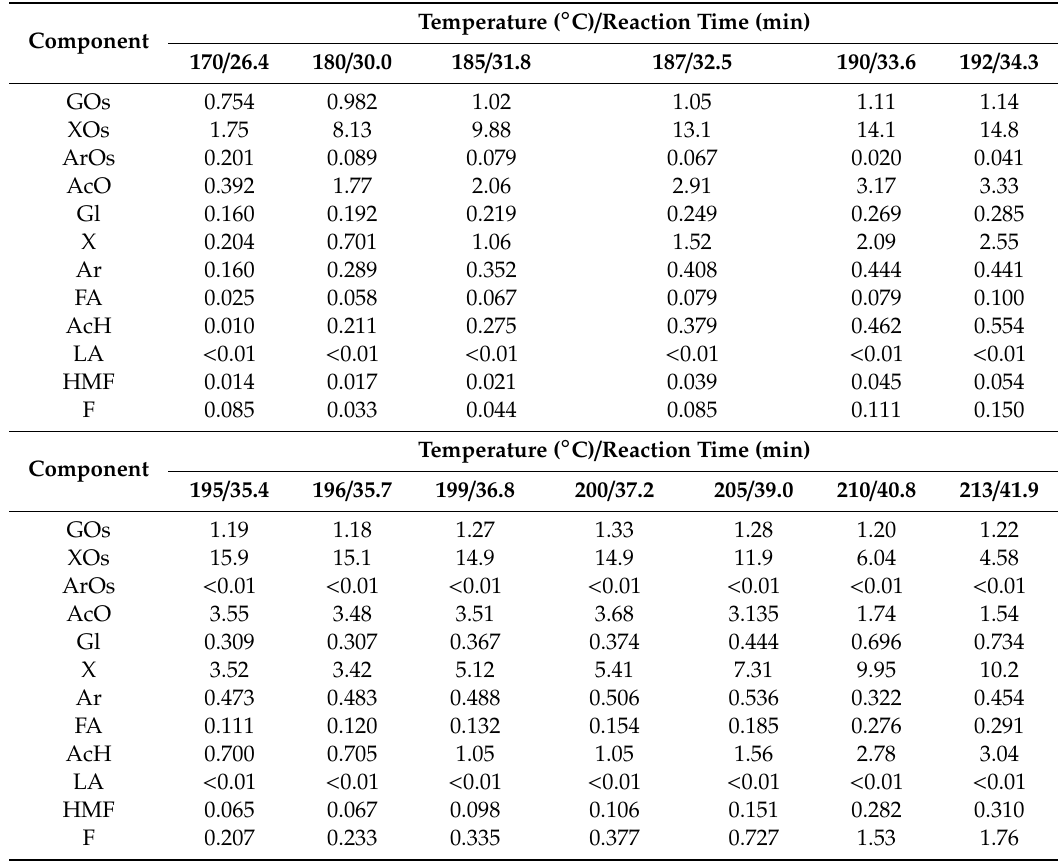
Table 2. Concentrations determined for the target products (in g / L) in the liquid phase from the first reaction